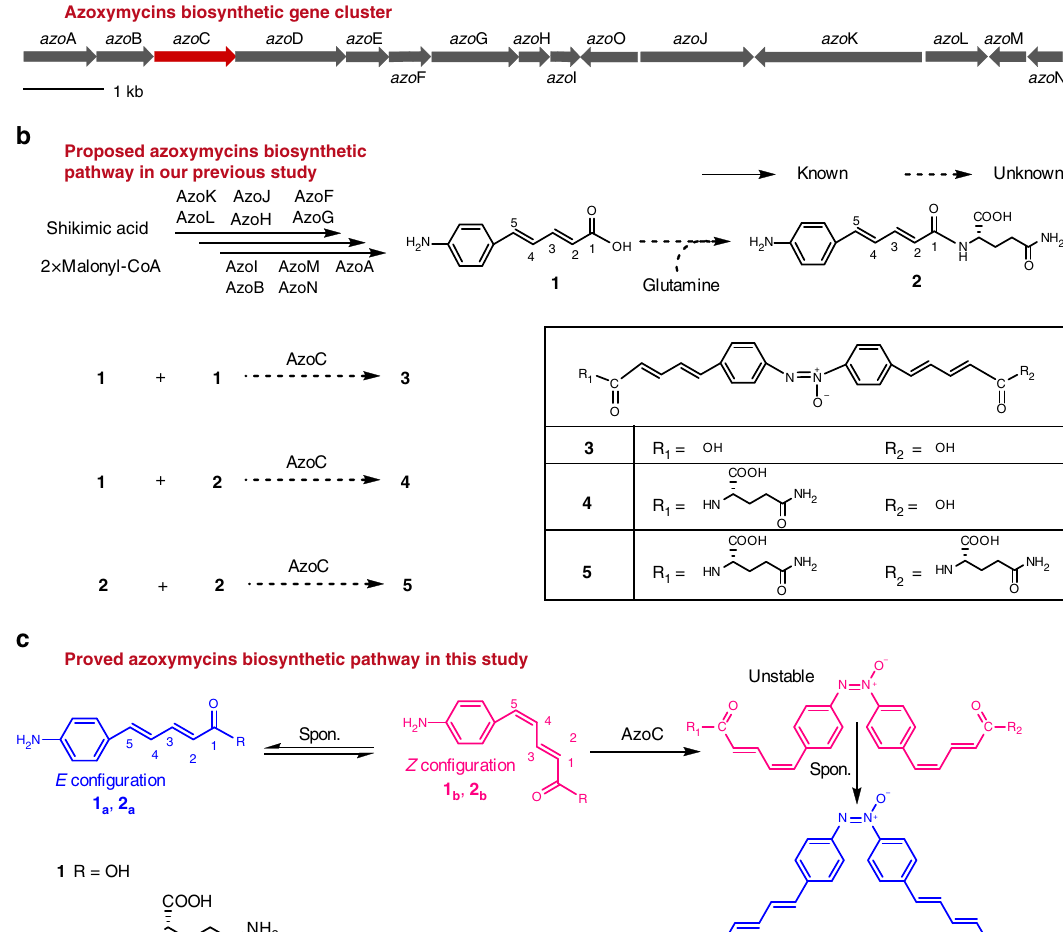
caused the accumulation of two amine precursors ( 1 and 2 ), and